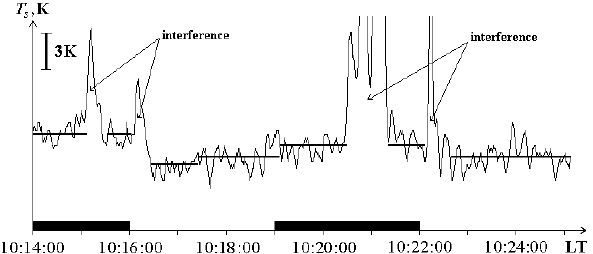
Fig. 2. Temporal evolution of the signal temperature T s obtained on 20 September 1998 at f = 598MHz. The pump wave frequency is f 0 = 5 . 455MHz. The “Sura” “on” periods are shown by black bars; radio interference is shown by arrows. Horizontal solid lines correspond to average values of T s over “on” and “off” periods. The jump of T s by 0.5K at 10:17:10LT corresponds to the change in the elevation angle β from 64 ◦ to 59 ◦ .